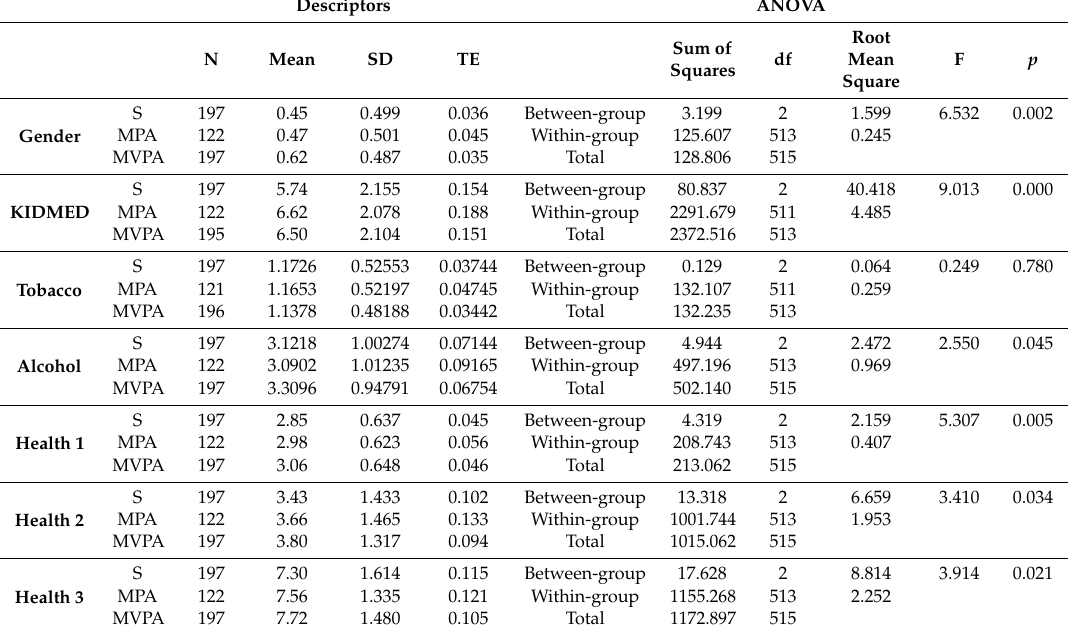
Table 1. Analysis of the variance according to gender, eating habits (KIDMED), tobacco consumption, alcohol consumption and health. Classification by level of physical activity